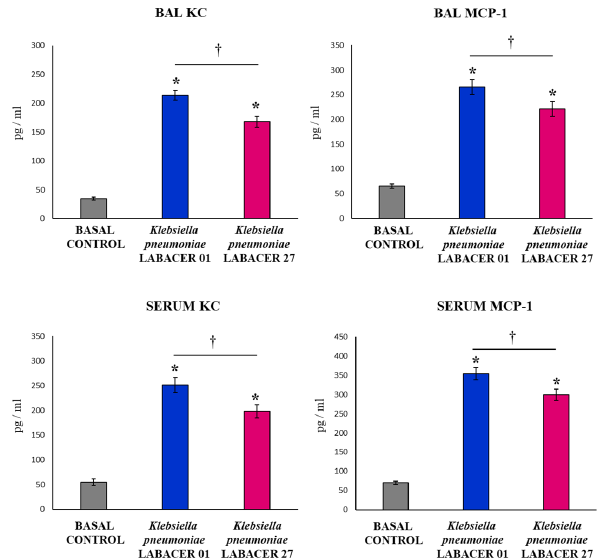
Figure 4. Variations in the inflammatory chemokines in the respiratory tract and blood induced by KPC-2-producing hypermucoviscous ST25 strains of Klebsiella pneumoniae . Immunocompetent adult BALB/c mice (six weeks) were nasally challenged with K. pneumoniae LABACER 01 or LABACER 27. Two days after challenge, the KC and MCP-1 levels were determined in broncho-alveolar lavage (BAL) and blood samples. Results represent data from three independent experiments. Asterisks (*) indicate significant differences from the uninfected control group (basal control), p < 0.05. The crosses (†) indicate significant differences between the indicated groups, p < 0.05.